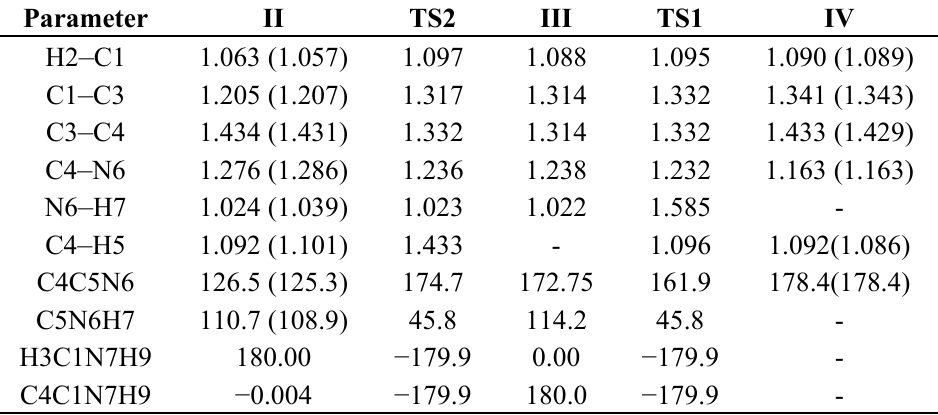
Table 3. Optimized parameters (bond lengths in Å and bond angles and dihedral angles in degrees of Z-HC≡CCH=NH(II) a , Transition States (TS1 and TS2), the Intermediate, CH =C=C=NH(III) and CH =CHC≡N(IV) b which have been calculated using 2 2 B3LYP/aug-cc-pvdz level of theory. Parameter